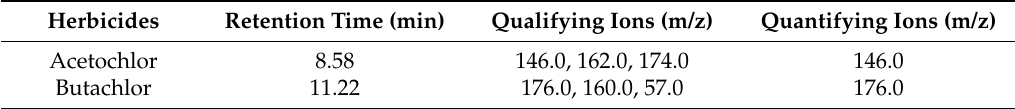
Table 3. Gas chromatography-tandem mass spectrometry (GC-MS) parameters of acetochlor and butachlor.